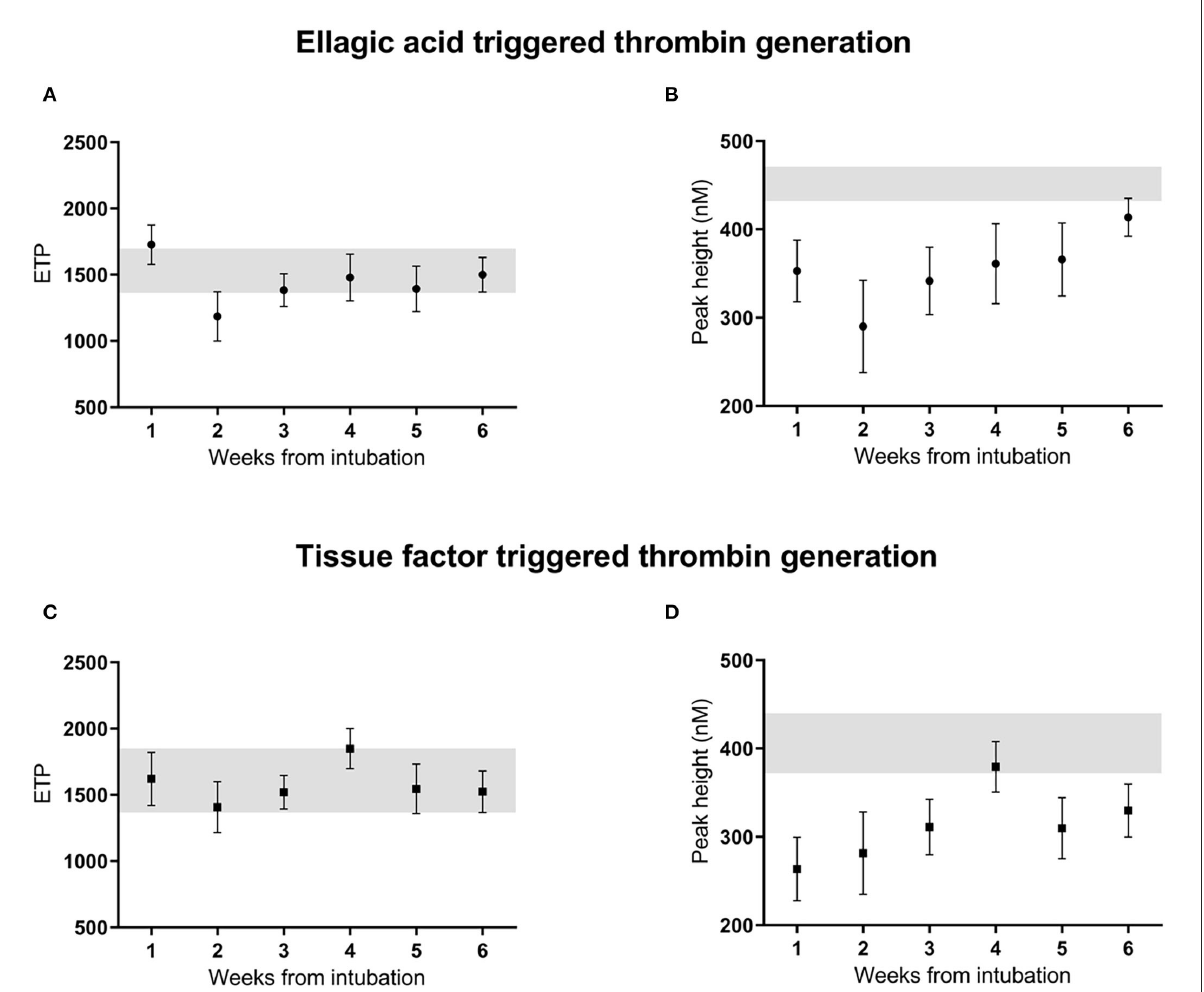
FIGURE1 Thrombin generation ETP (A,C) and peak height (B,D) initiated by ellagic acid and tissue factor, unadjusted measurements over 6 weeks from intubation in critically ill patients with COVID-19 infection. Reference range of normal pooled plasma shown in gray. ETP, endogenous thrombin potential; EA, ellagic acid; TF, tissue factor,